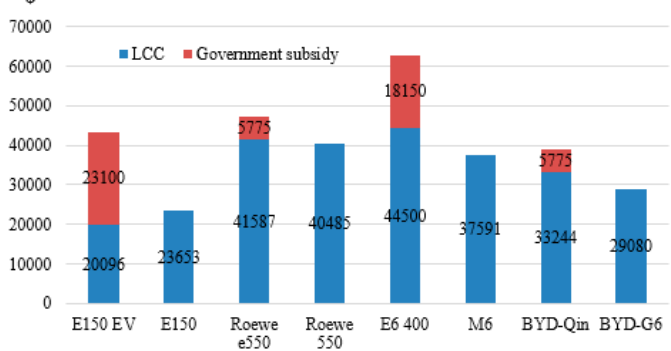
Figure 5. The TOCs for conventional vehicles, battery vehicles and plug-in hybrid gasoline-electric vehicles (with government subsidy).